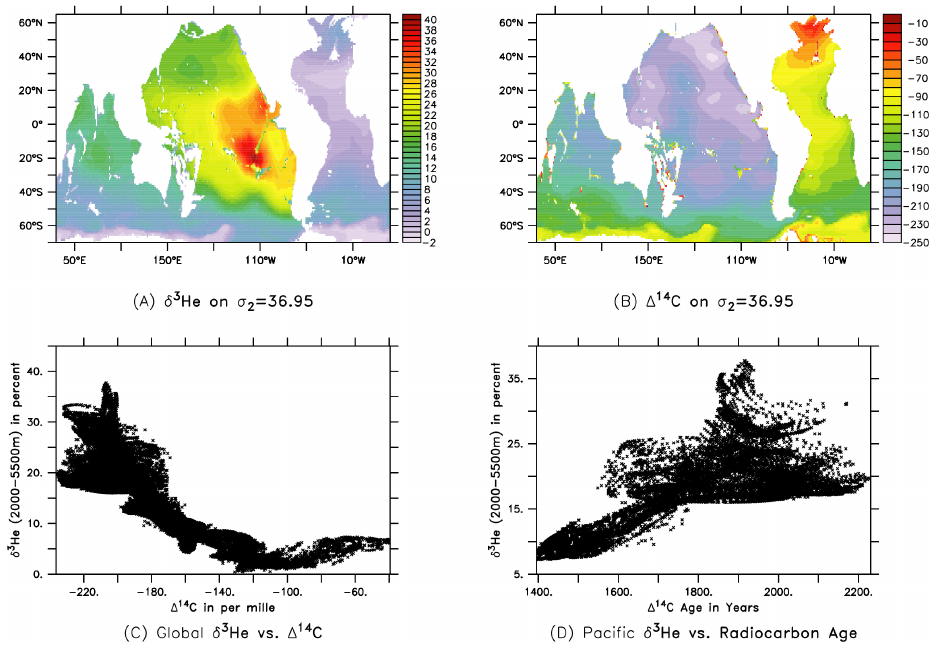
Figure 1. δ 3 He and radiocarbon in the ocean. (a) δ 3 He from Bianchi et al. (2010) on σ 2 ( potential density relative to 2000m minus 1000kgm − 3 ) of 36.95. (b) (cid:49) 14 C on σ 2 = 36 . 95 from Key et al. (2004). (c) Vertically averaged δ 3 He vs. vertically averaged (cid:49) 14 C (2000– 5500m). (d) Vertically averaged δ 3 He vs. radiocarbon age, 2000–5500m, Pacific sector